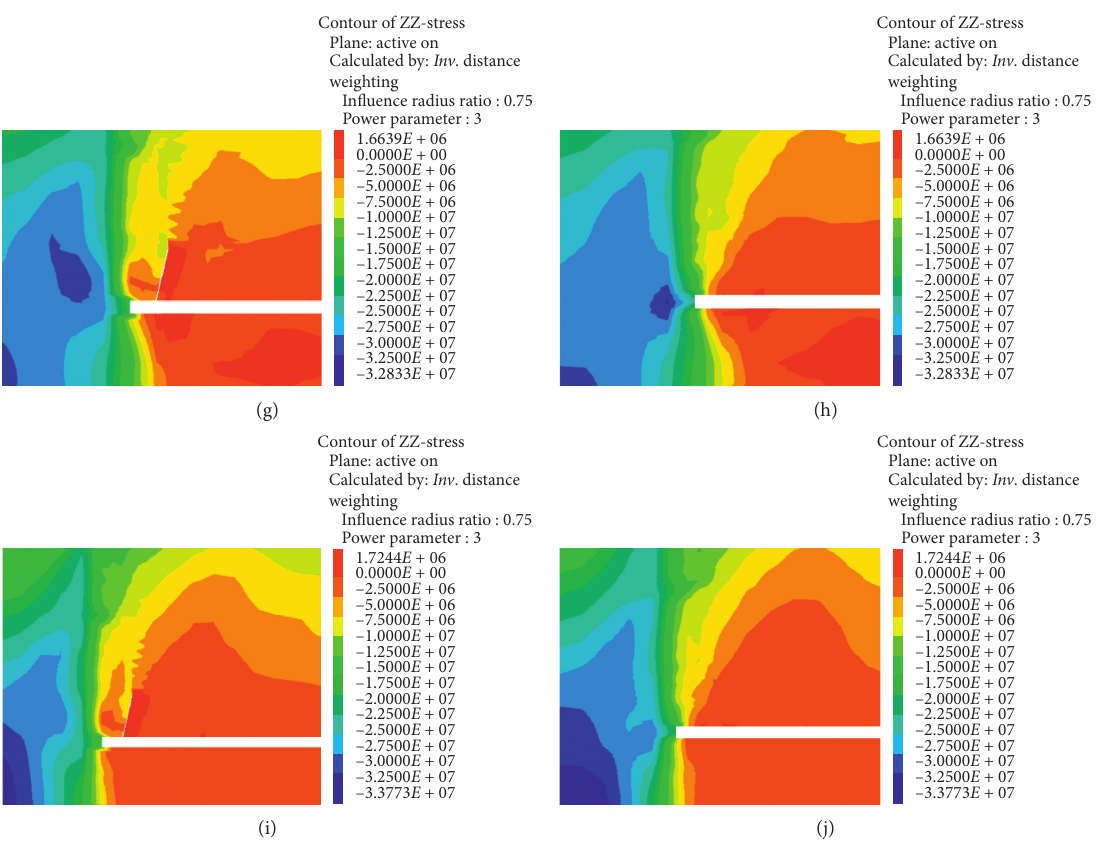
Figure 8: Lateral stress of working face of two working conditions. (a) #7 survey line with presplitting blasting. (b) #7 survey line without presplitting blasting. (c) #8 survey line with presplitting blasting. (d) #8 survey line without presplitting blasting. (e) #9 survey line with presplitting blasting. (f) #9 survey line without presplitting blasting. (g) #10 survey line with presplitting blasting. (h) #10 survey line without presplitting blasting. (i) #11 survey line with presplitting blasting. (j) #11 survey line without presplitting